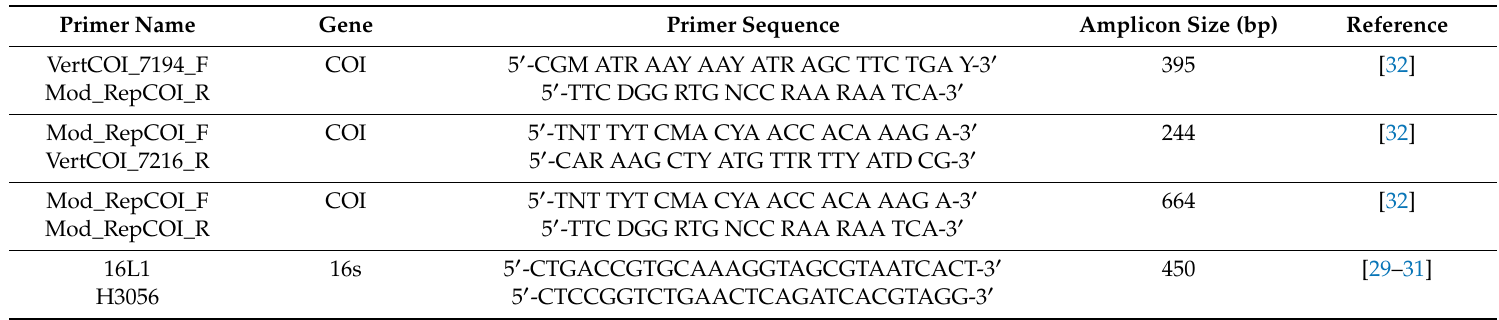
Table 2. Primer pairs used to amplify vertebrate host DNA from Culex atratus and Culex pilosus blood meals that were collected in southern Florida,